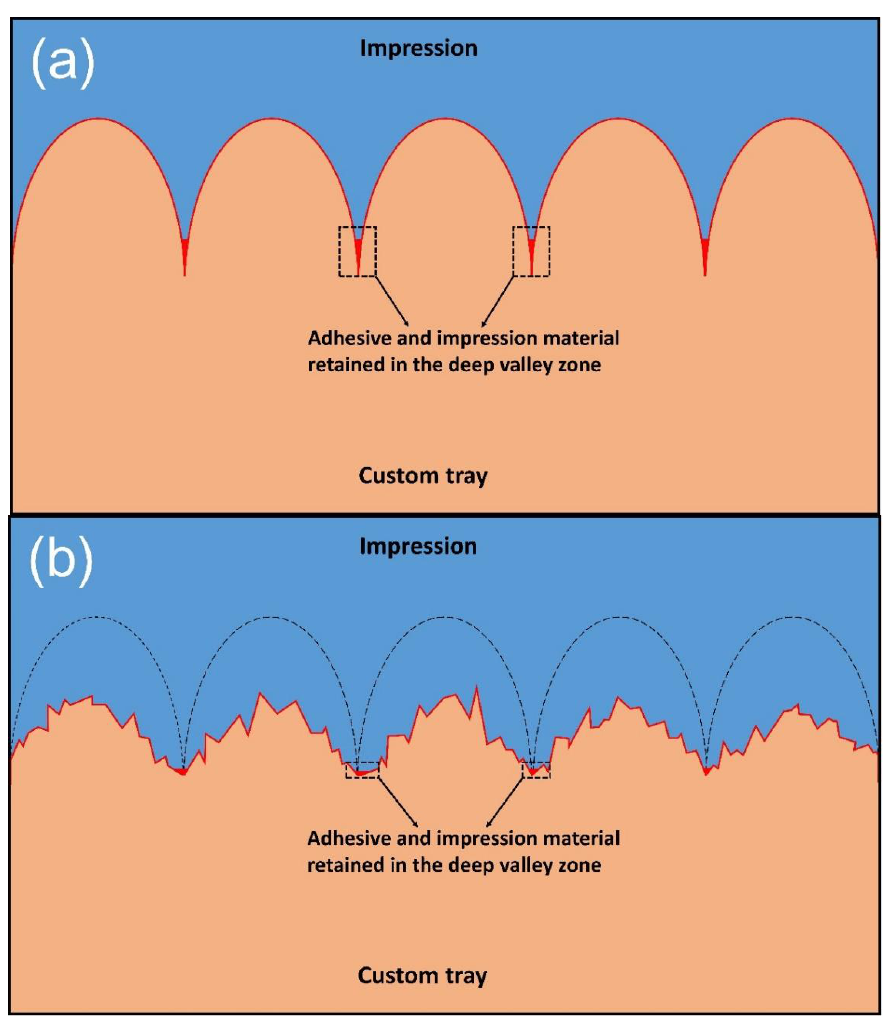
Figure 12. The adhesive and impression material retained in the deep valley zone. ( a ) Before GB; ( b ) After GB. In studies of bonding between custom trays and impression/adhesive systems, different crosshead speeds have been utilized, ranging from 5 mm/min to 508 mm/min [16,23,38,39]. Since the strain rate may influence the result of bond strength, the crosshead speed should be related to the